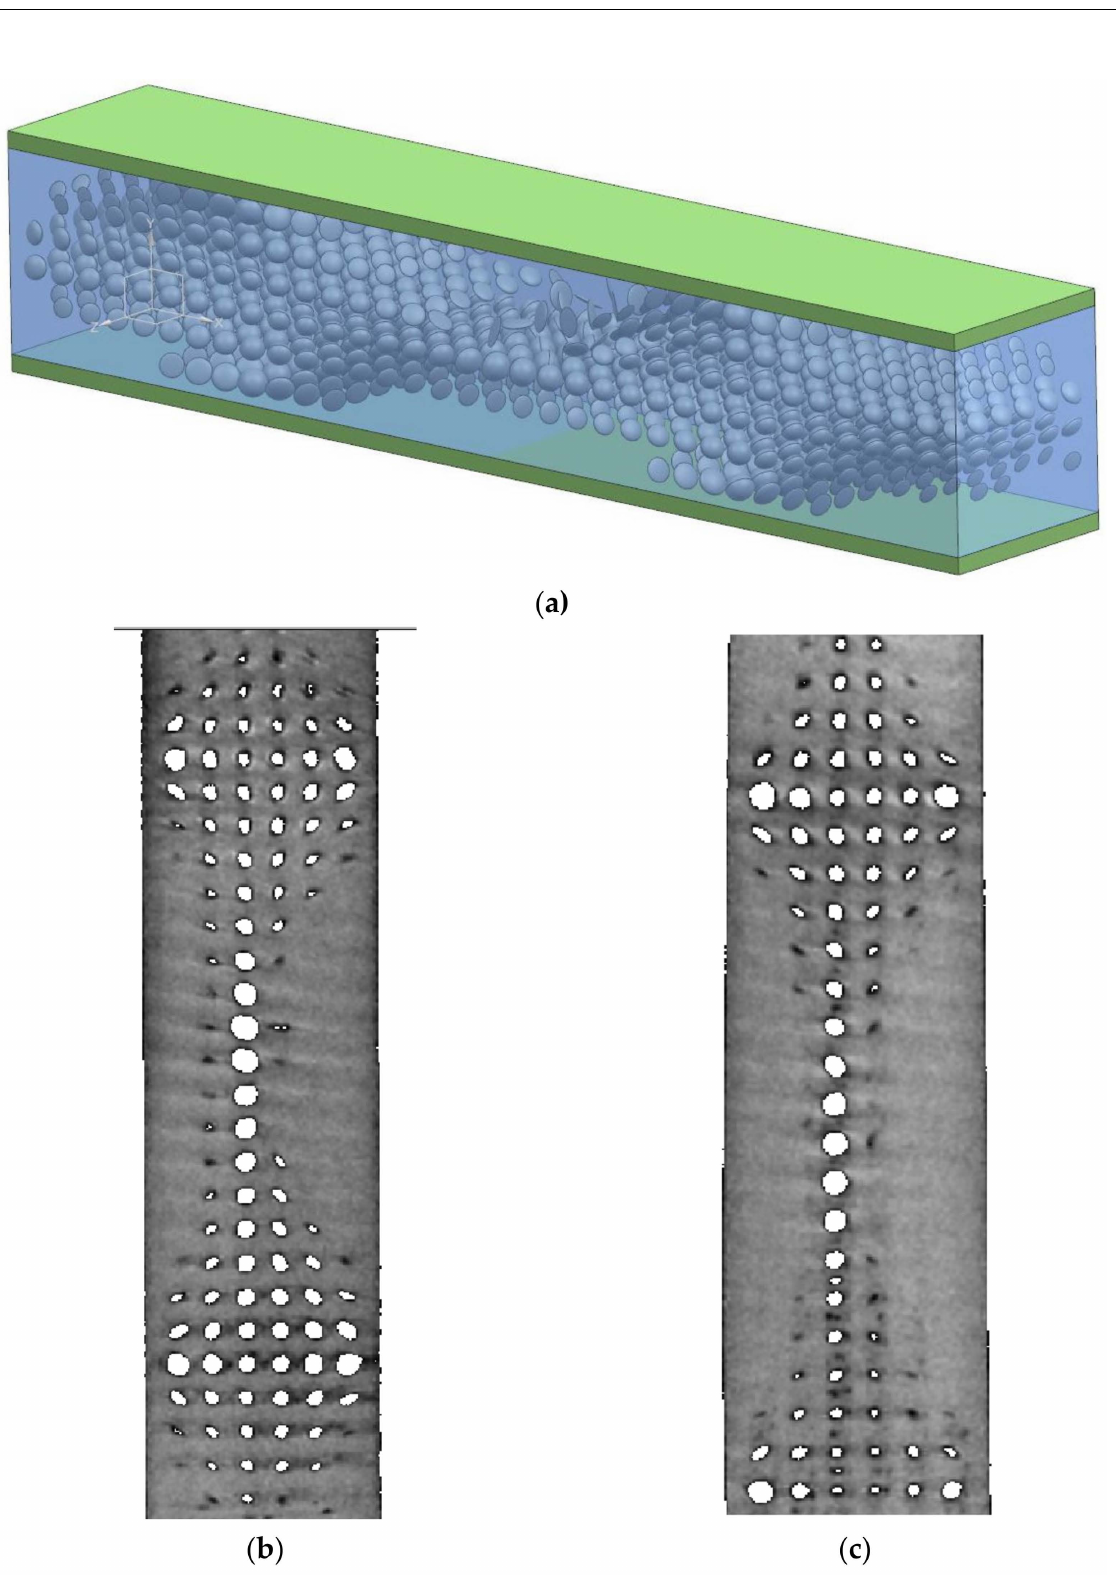
Figure 5. Restored 3D geometry ( a ), CT scans for longitudinal printing ( b ), and transversal printing ( c